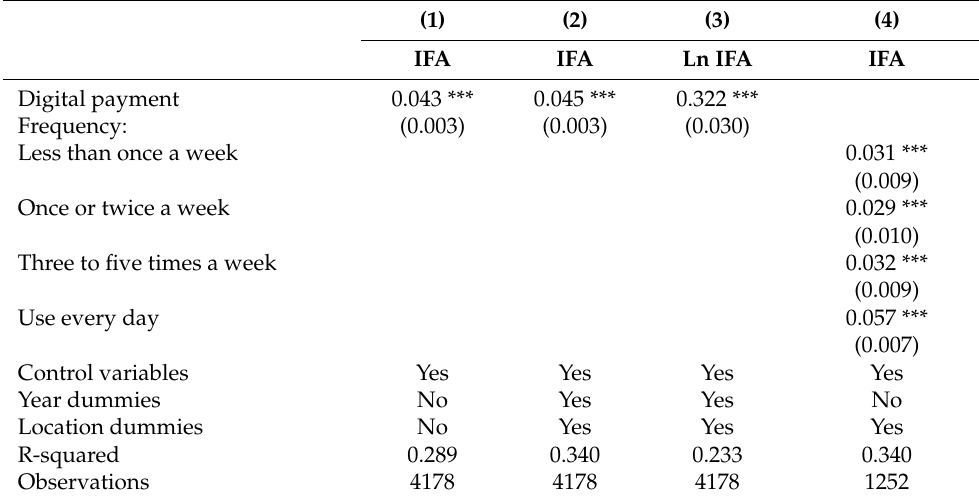
Table 8. Digital payment adoption and financial availability (estimated by OLS models).